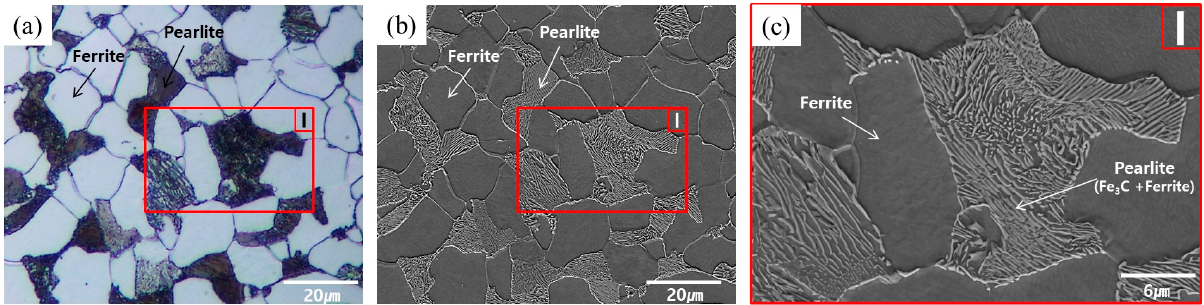
Figure 3. Microstructures of raw material: ( a ) OM image (×1000); ( b ) SEM image (×1000); ( c ) SEM image (×3000).